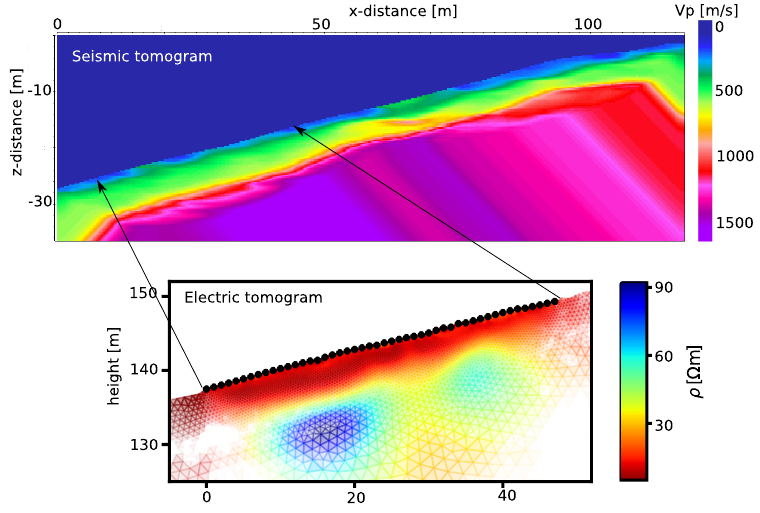
Figure 5. Seismic and unconstrained electric resistivity